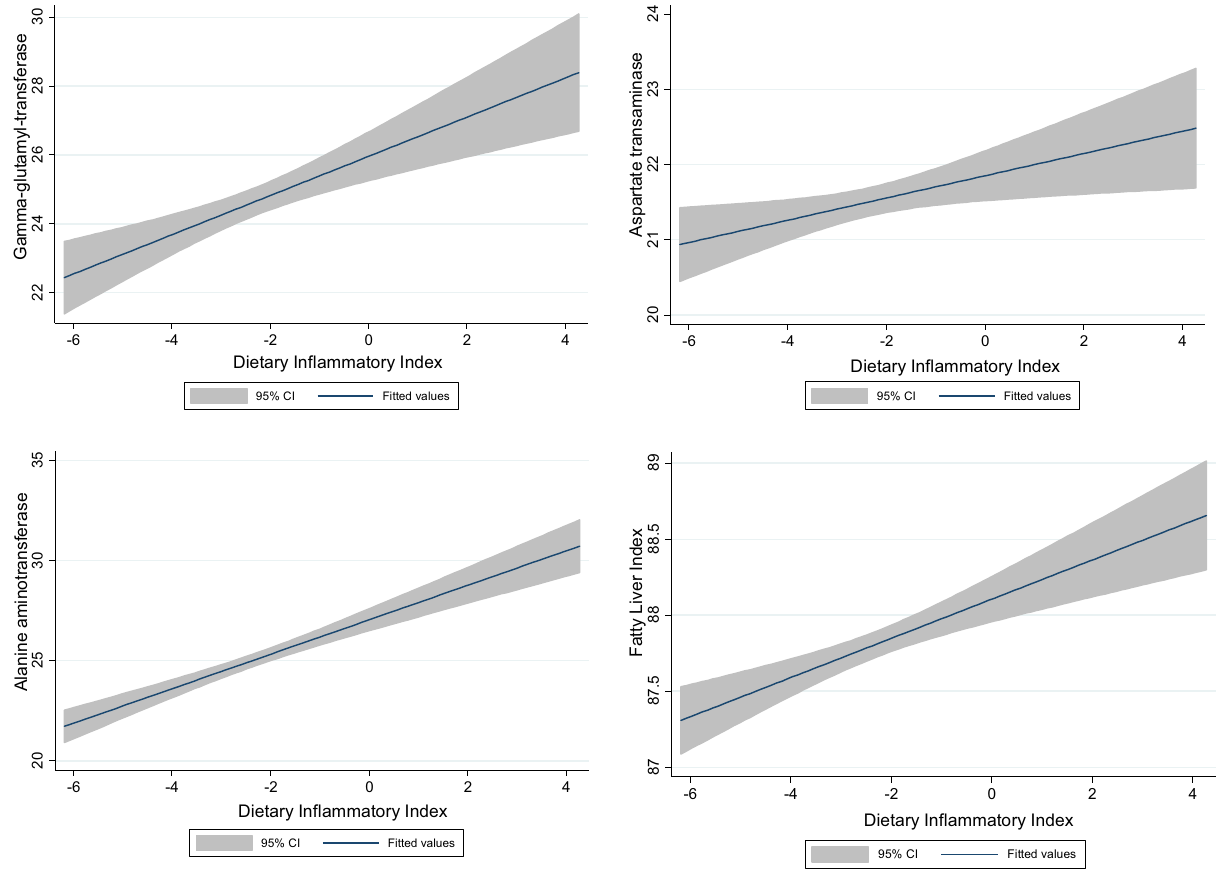
Figure 1. Associations between markers of liver status and dietary inflammatory